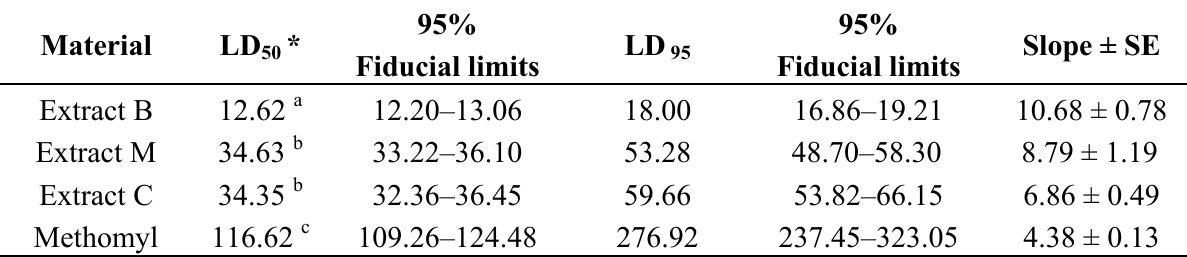
Table 2. Probit analysis for contact toxicity of extracts B, M, and C and methomyl after topical application to Monacha cantiana .